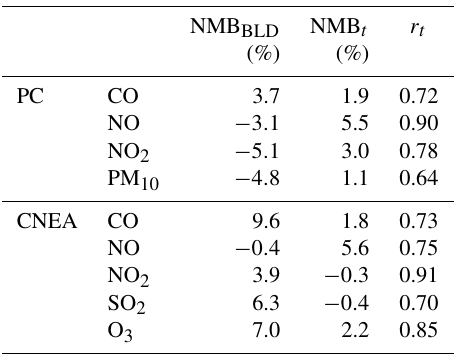
Table 4. Summary of the evaluation statistics used in the random forest predictive model for the testing dataset ( t ) and evaluation pe- riod (BLD). NMB BLD NMB t r t